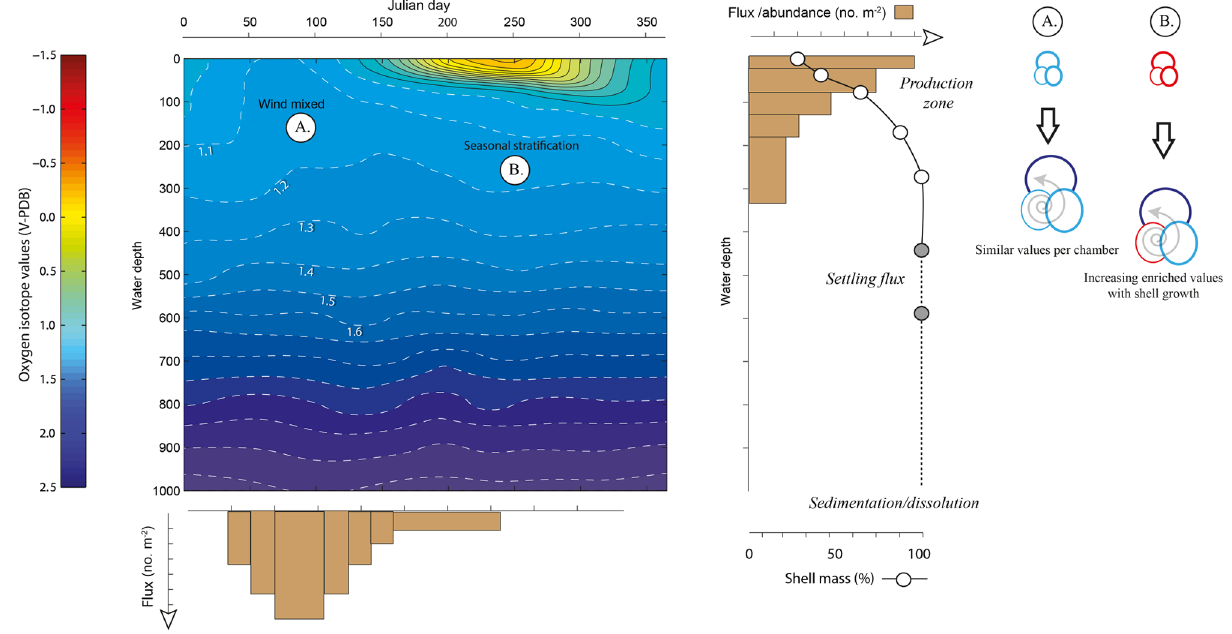
Figure 1. Schematic to show the competing individual and population dynamics that may contribute to the variance within the δ 18 O of a population. Growing seasons may be exaggerated or minimized by water column properties (i.e. rapid population turnover reflecting “bloom” conditions) as highlighted by the uneven widths of the flux histogram. Likewise, rapid growth during juvenile chamber formation may lead to larger offsets (Berger et al., 1978a; Mulitza et al., 1999a) as well as large differences between the surface and deep equilibrium δ 18 O; however, this is offset by the percentage that these juvenile chambers contribute to the whole shell δ 18 O. This is particularly influential if scenario B (a stratified water column) occurs rather than scenario A (a well-mixed water column). Schematic modified from Metcalfe et al.